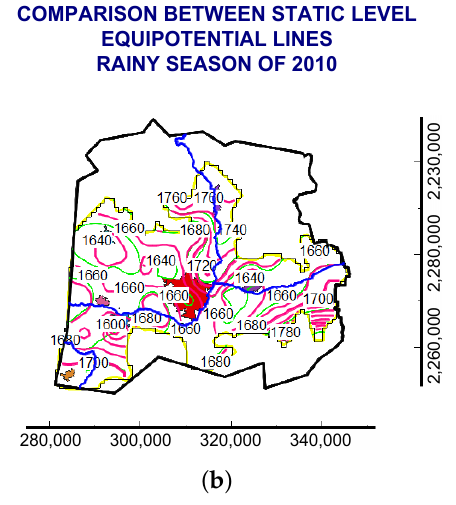
Figura 2.10: Comparaci´on entre las l´ıneas equipotenciales de los niveles piezom´etricos calculados por el modelo (Color Rosa) y los medidos en campo (Color Verde) de la temporada de Lluvias. Figure 11. Rainy season. ( a ) Hydraulic head in steady state, where the highest head is represented by red and the lowest head by dark blue. ( b ) Comparison between the equipotential lines of the piezometric levels calculated by the model (pink color) and those measured in the field (green